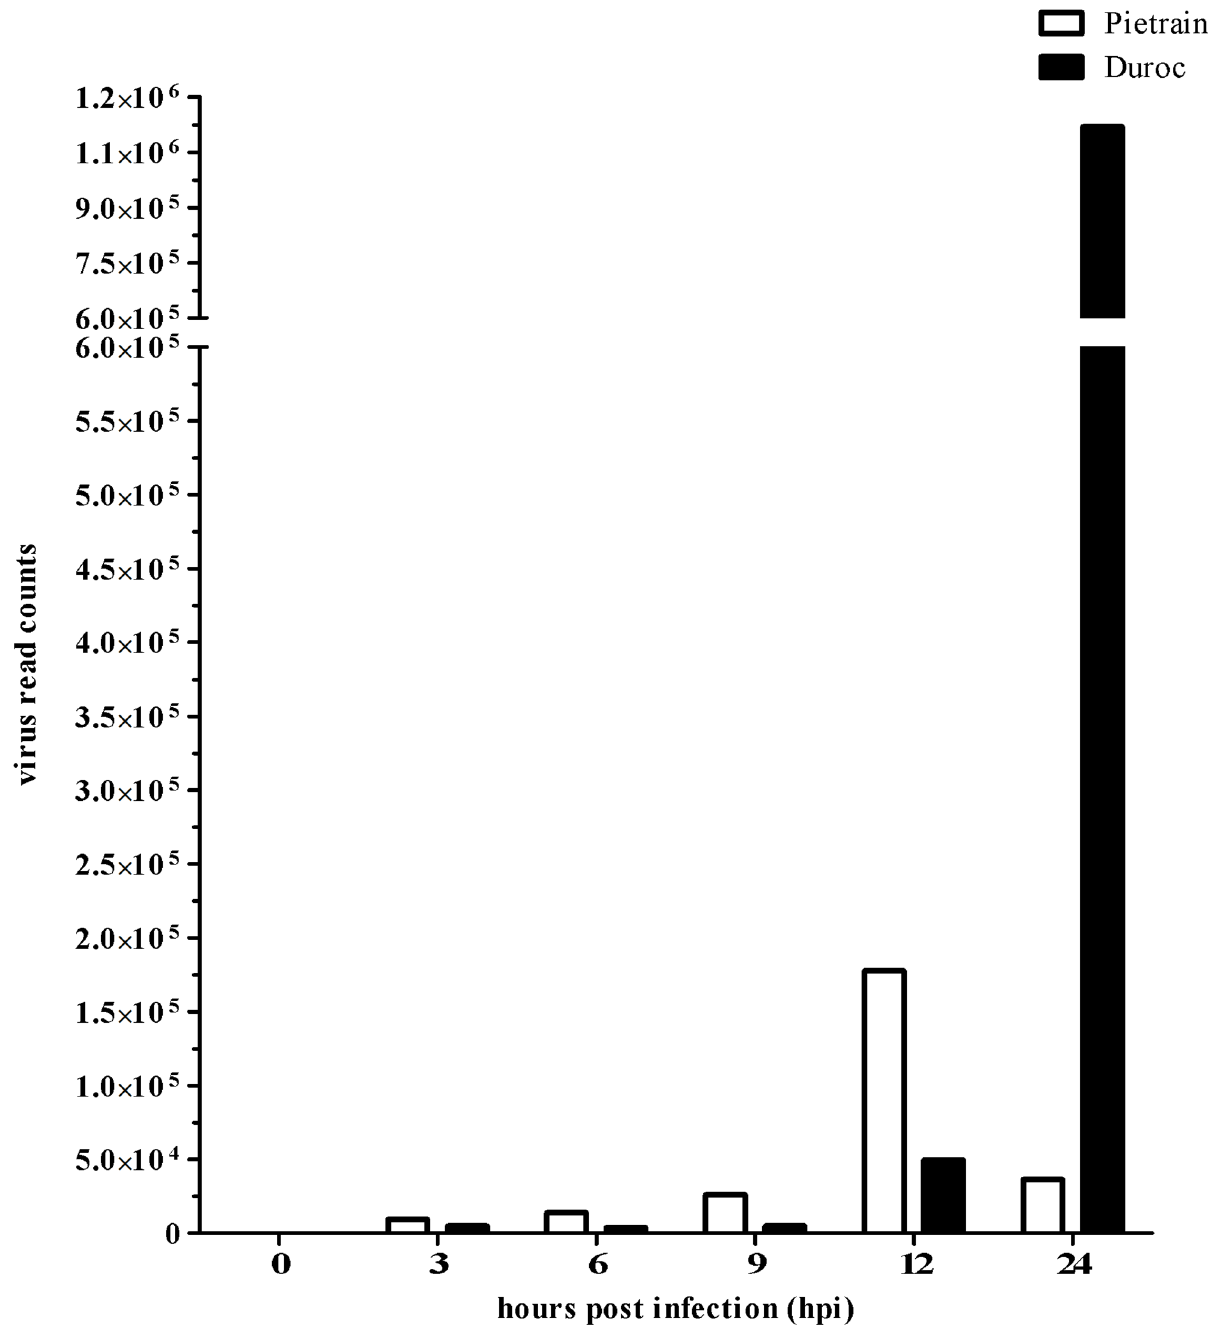
Fig 1. Lelystad virus (LV) growth in lung DCs. Virus read counts in Pietrain (white bar) and Duroc (black bar) lung DCs before (0 h) and post (3, 6, 9, 12, 24 hpi) PRRSV infection.